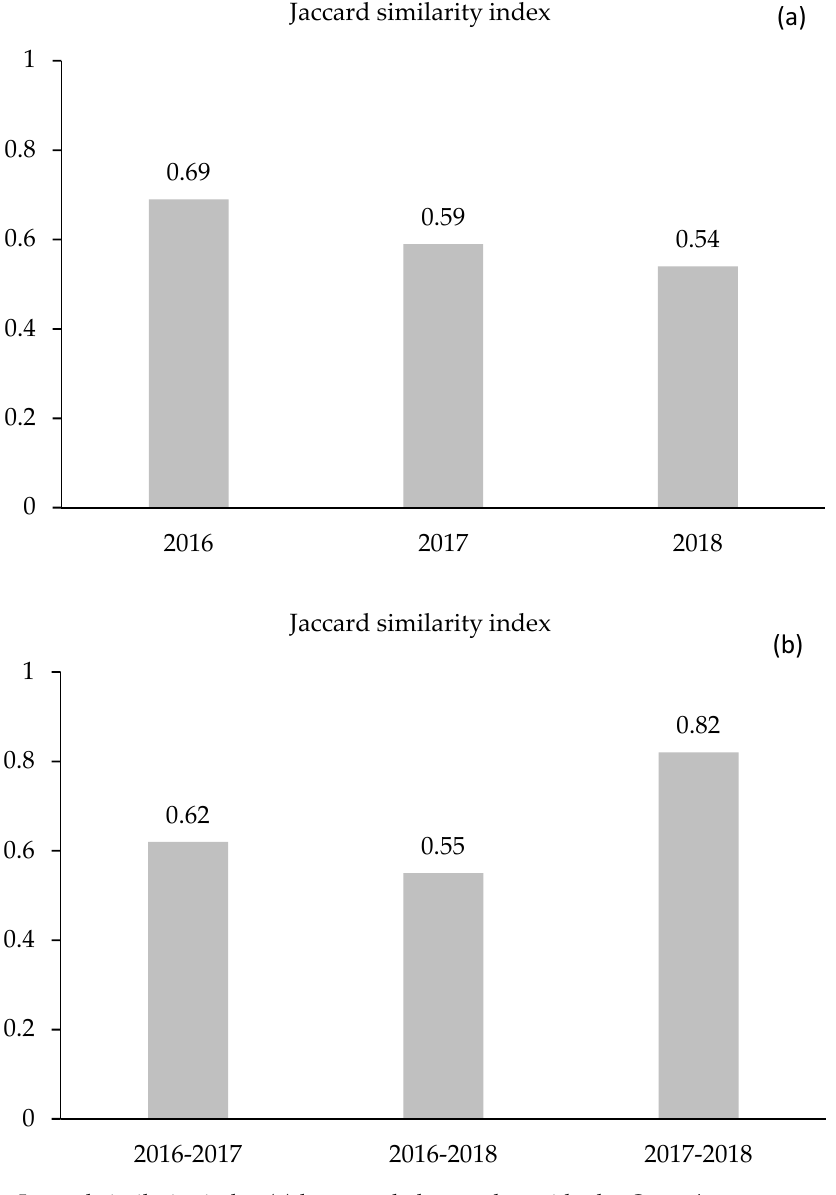
Figure 3. Jaccard similarity index ( a ) between below and outside the Casuarina canopy surveys in